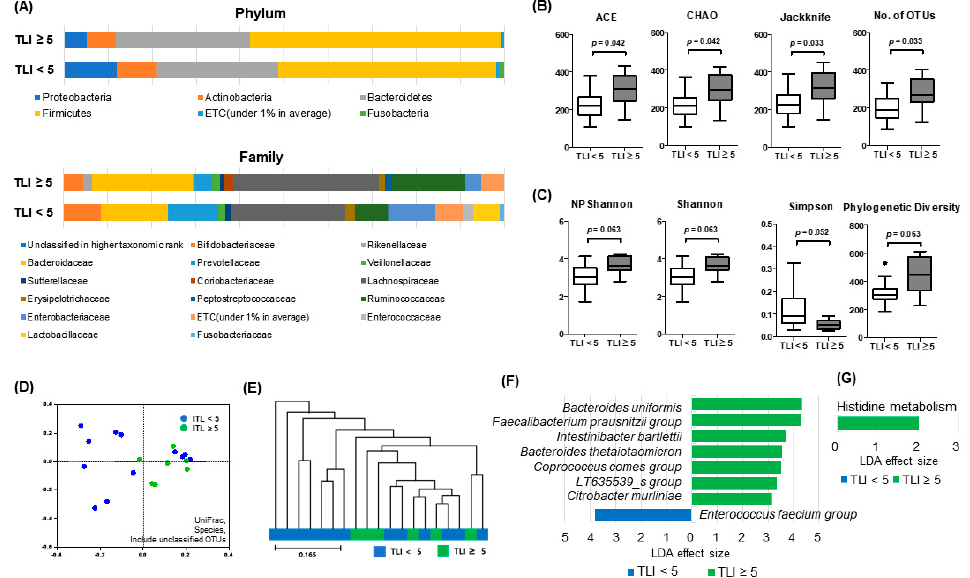
Figure 4. Microbial composition analysis of fecal samples obtained from IBD patients with trough level of infliximab (TLI) ≥ 5 µ g / mL and TLI < 5 µ g / mL. ( A ) Stacked bar chart of microbial composition at the phylum and family level; ( B ) microbial richness assessed by ACE, CHAO, Jackknife, and number of operational taxonomic units (OTUs); ( C ) biodiversity index, including NPShannon, Shannon, and Simpson indices, and phylogenetic diversity; ( D ) PCoA plot; ( E ) UPGMA dendrogram; ( F ) linear discriminant analysis e ff ect size (LEfSe); and ( G ) phylogenetic investigation of communities by reconstruction of unobserved states (PICRUSt) analysis.